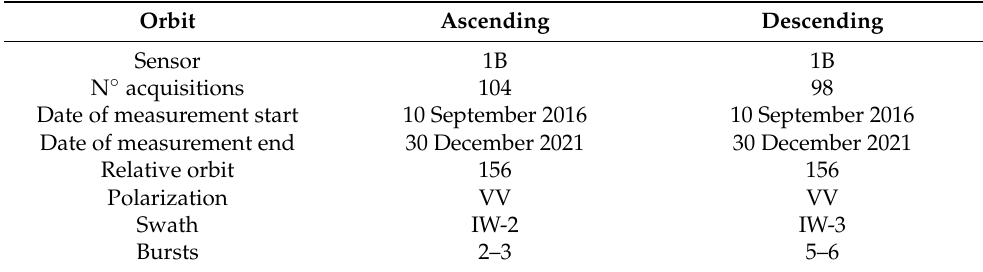
Table 1. Data set including the main features of Sentinel 1. Orbit Ascending